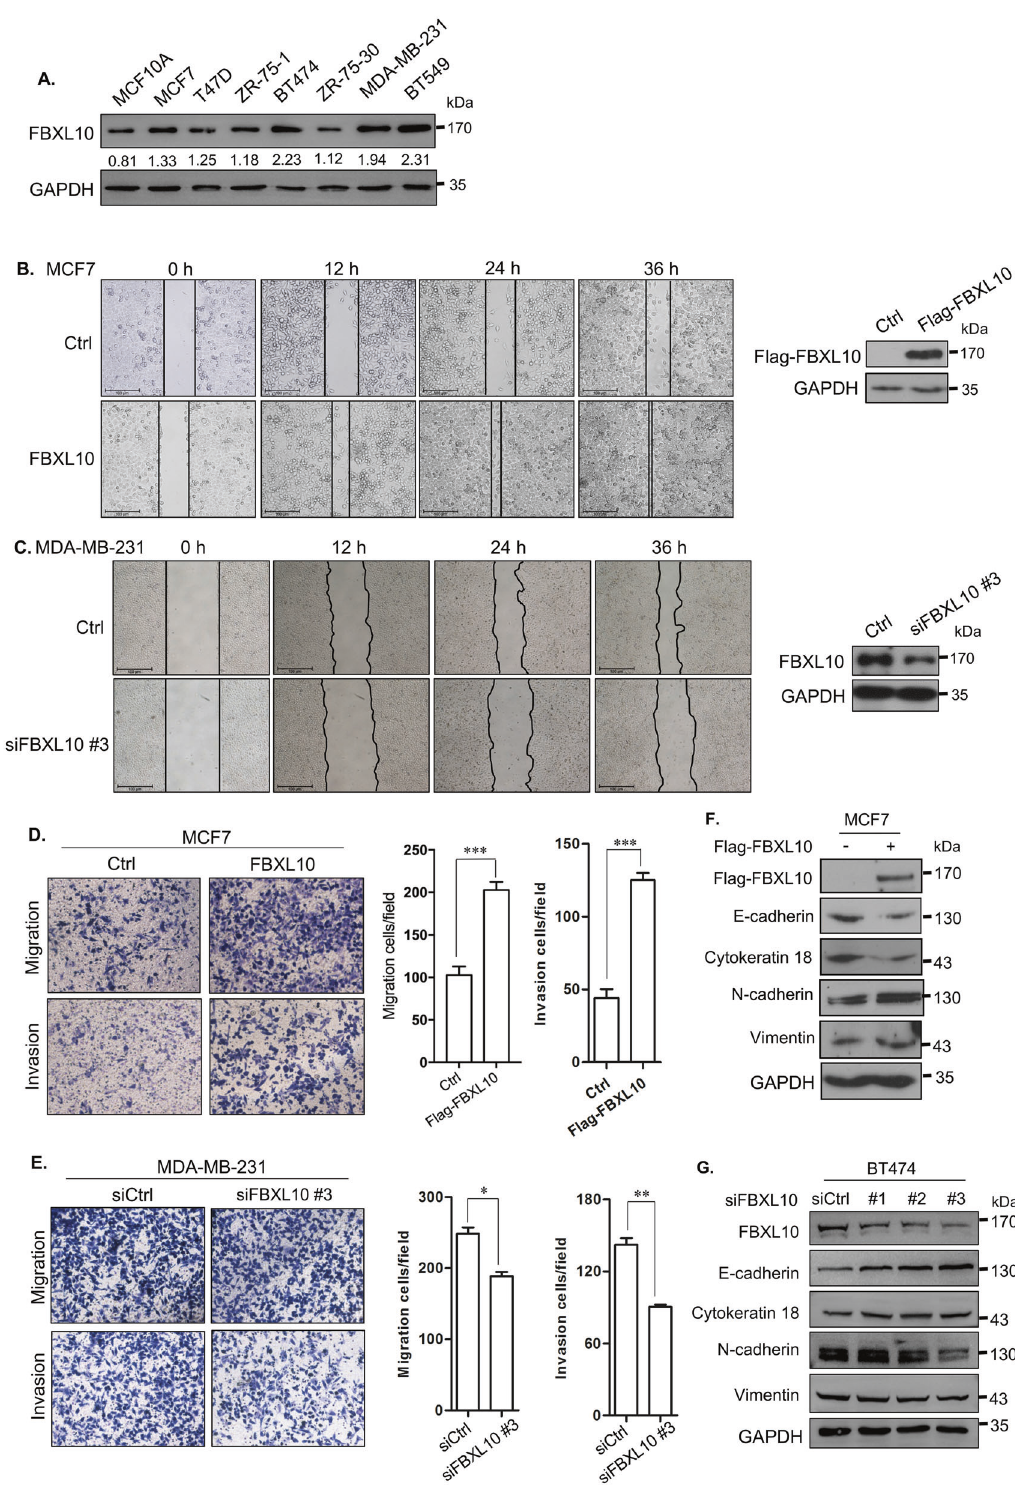
Fig. 2 FBXL10 modulates breast cancer cells motility, invasion via regulating EMT. A Western blot detected the expression of FBXL10 in normal breast epithelial cell and different types of breast cancer cells. The relative expression of FBXL10 was normalized by GAPDH with gray level ratio analysis. B , C Scratch wound-healing assay evaluated the effect of FBXL10 overexpression or knockdown on the migration of MCF7 ( B ) and MDA-MB-231 ( C ) cells respectively. D , E Transwell assay assessed the effect of FBXL10 overexpression or knockdown on the migration and invasion of MCF7 ( D ) and MDA-MB-231 ( E ) cells respectively. The bar graph showed the number of migrating and invading cells for each category of cells with three independent replications. * P < 0.05; ** P < 0.01; *** P < 0.001. F Western blot assay tested the EMT markers (E- cadherin, Cytokeratin 18, N-cadherin and Vimentin) in MCF7 cells with FBXL10 overexpression. G Western blot tested the effect of FBXL10 knockdown with siRNAs on the expression of EMT markers in BT474 cells.